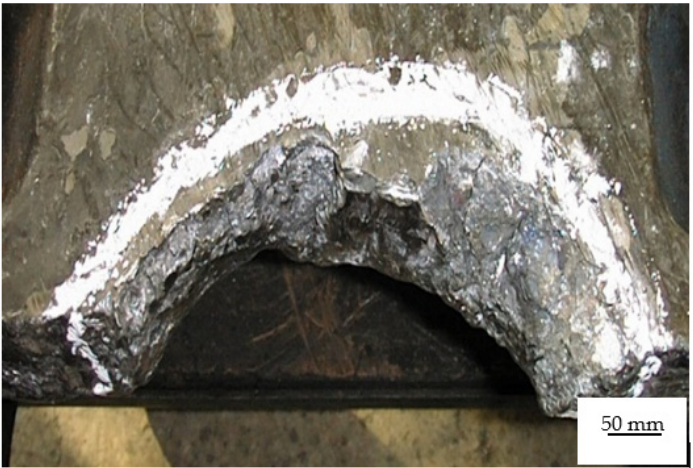
Figure 5. The shape of the cracks that appear in the active area of the trimming dies made of the steel K